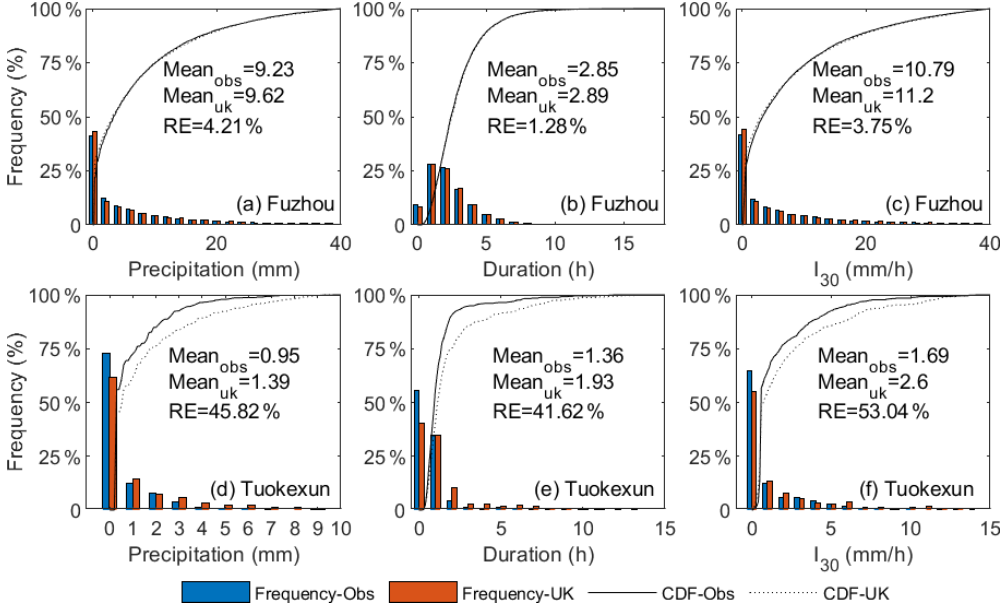
Figure 8. Frequency distribution of daily precipitation, duration, and maximum 30min intensity ( I 30 ) generated by CLIGEN using inputs based on observations and interpolation predicted parameters: Fuzhou station (a–c) and Tuokexun station (d–f) as